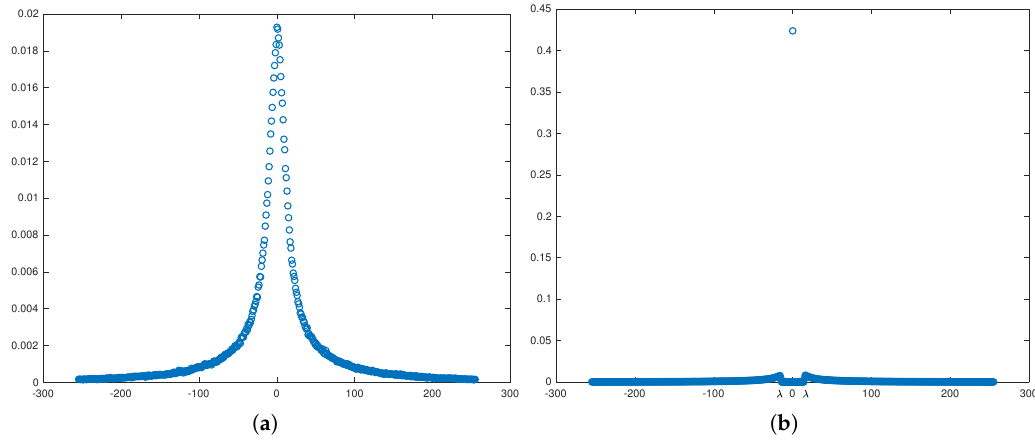
Figure 2. Construction of the target edge-histogram. ( a ) Histogram of gradient y s , t ; ( b ) histogram of thresholded gradient z s , t .